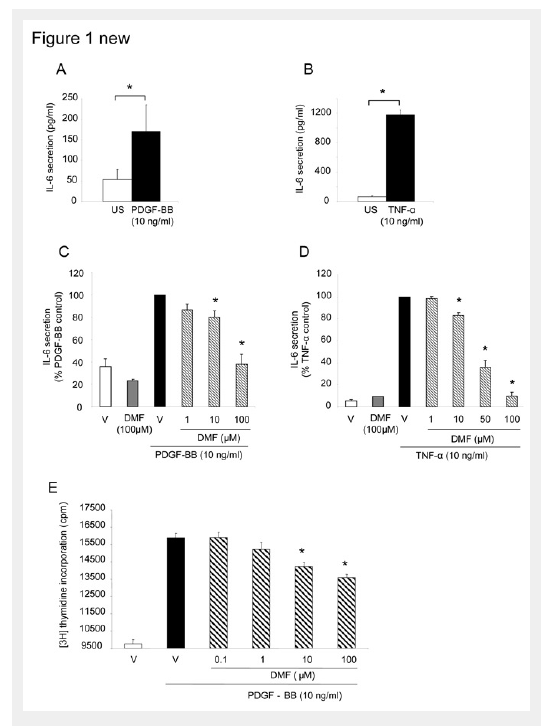
(A) IL-6 secretion induced by PDGF-BB (10 ng/ml) in human lung fibroblasts (n = 7). (*indicates p <0.05 student paired t-test). (B) TNF-α (10 ng/ml) stimulated IL-6 secretion in lung fibroblasts (n = 4) within 24h (* indicates p <0.0 5 student paired t-test). (C) DMF (1–100 µM) dose-dependently inhibited PDGF-BB or (D) TNF- α induced IL-6 secretion by lung fibroblasts (n = 5). The data is presented as mean ± SEM (* indicates p <0.05, one-way ANOVA). (E) DMF also inhibited PDGF-BB induced fibroblast proliferation. Data represents mean ± SEM (* indicates p <0.01, paired student’s t-test, two